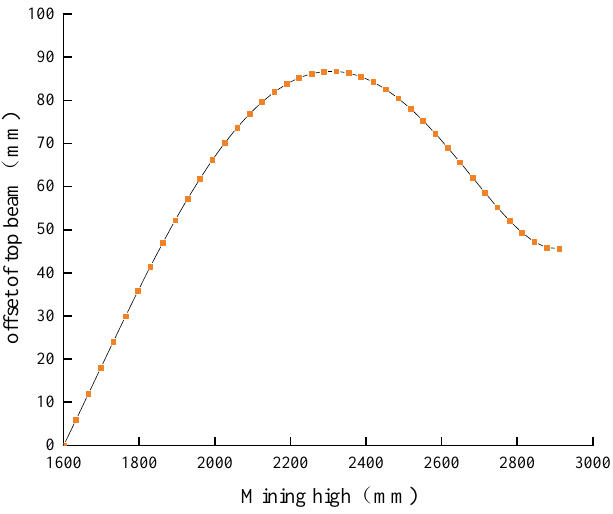
Figure 17. Variation of dip angles of columns of the ZC4800/16/30 backfilling hydraulic support. The offset of the top beam can reflect the overall stability of the support. In Figure 18, the offset of the top beam of the ZC4800/16/30 backfilling hydraulic support first increases and then decreases, and the maximum value is 86.7 mm. It is within a reasonable deflected range of the twisted pair from the perspective of engineering.